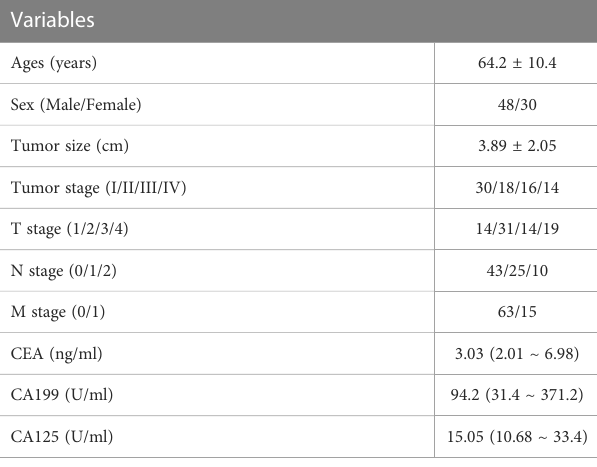
TABLE 1 Baseline characteristics of the study